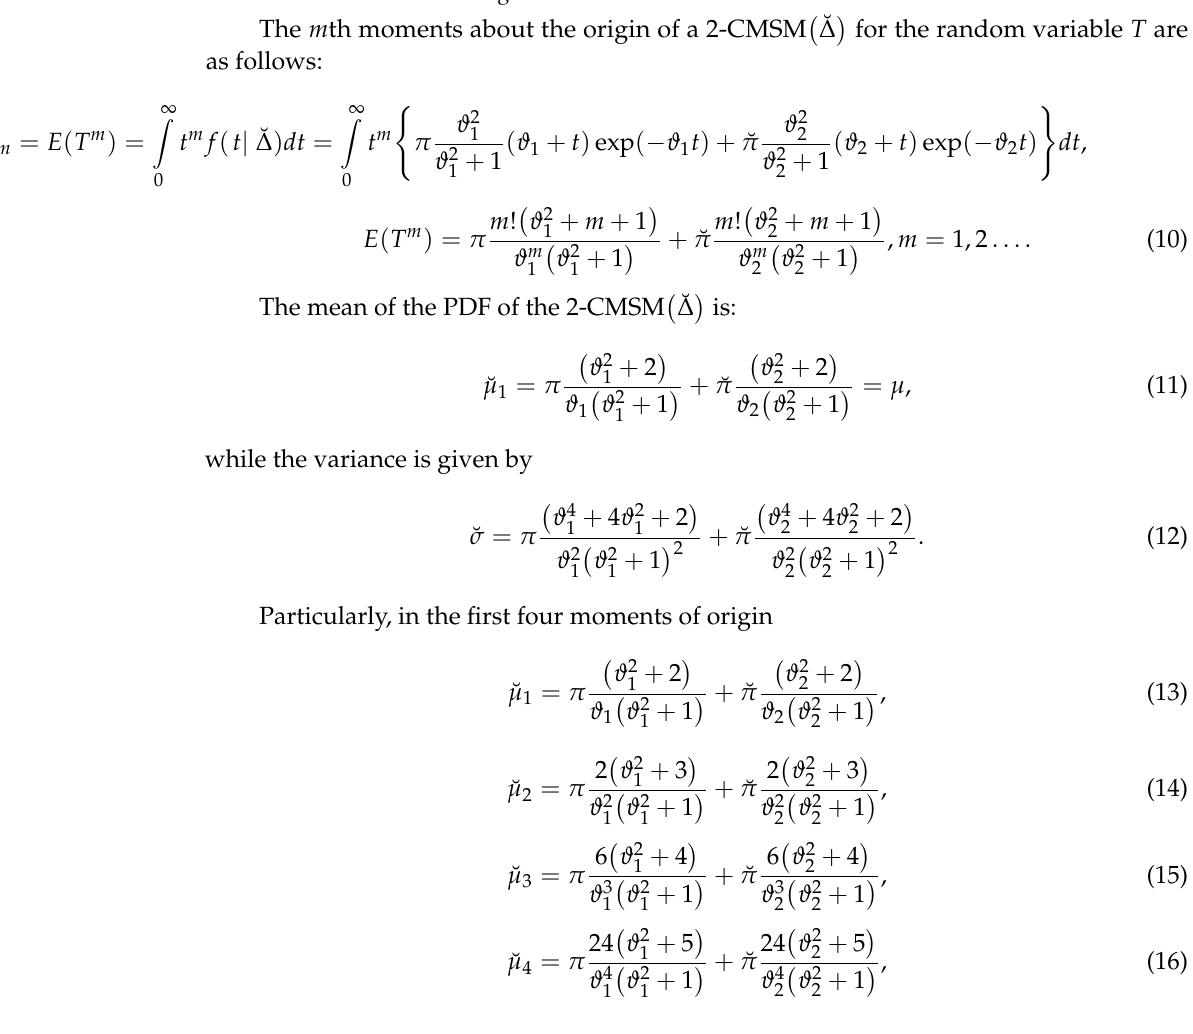
Fig. 3. Variations of Mean of 2-CMSM Figure 3. Variations of Mean of 2-CMSM (cid:0) ˘ ∆ (cid:1)